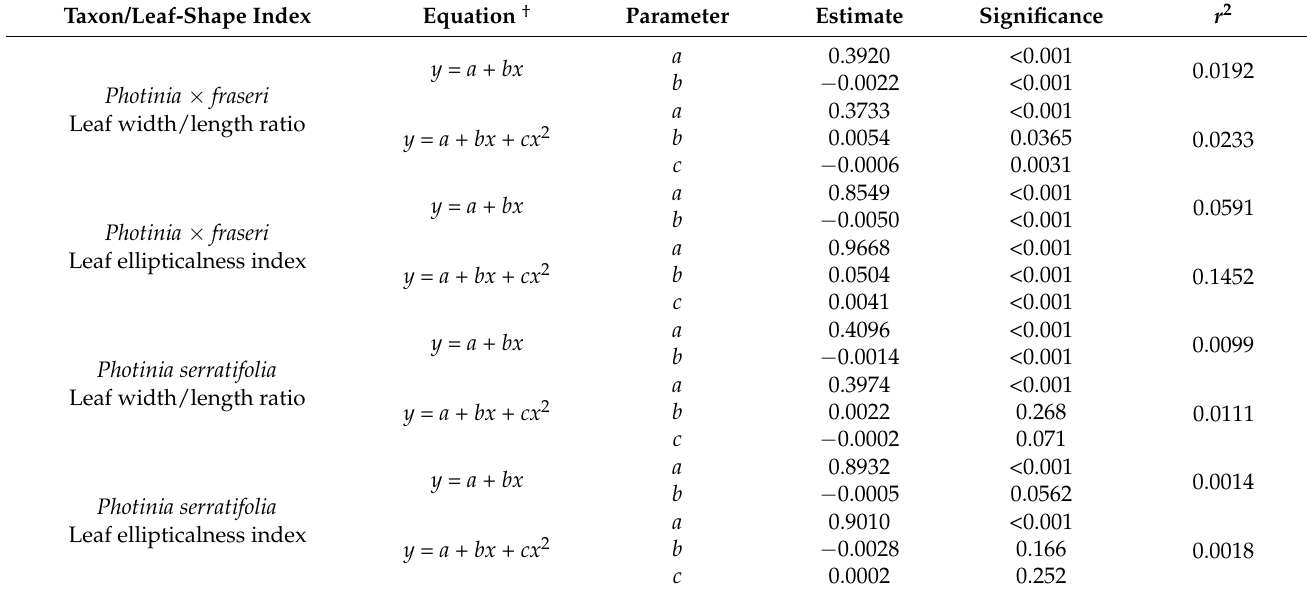
Table 1. Regression statistics of the leaf-shape index vs. sampling